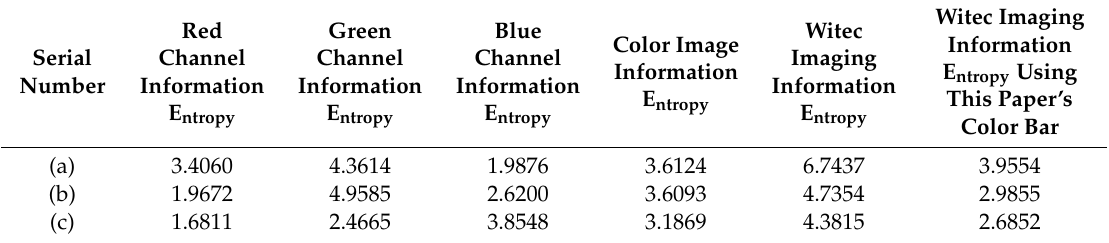
Table 6. The entropy of the Figure 21 Witec images and images generated by this paper’s algorithm.